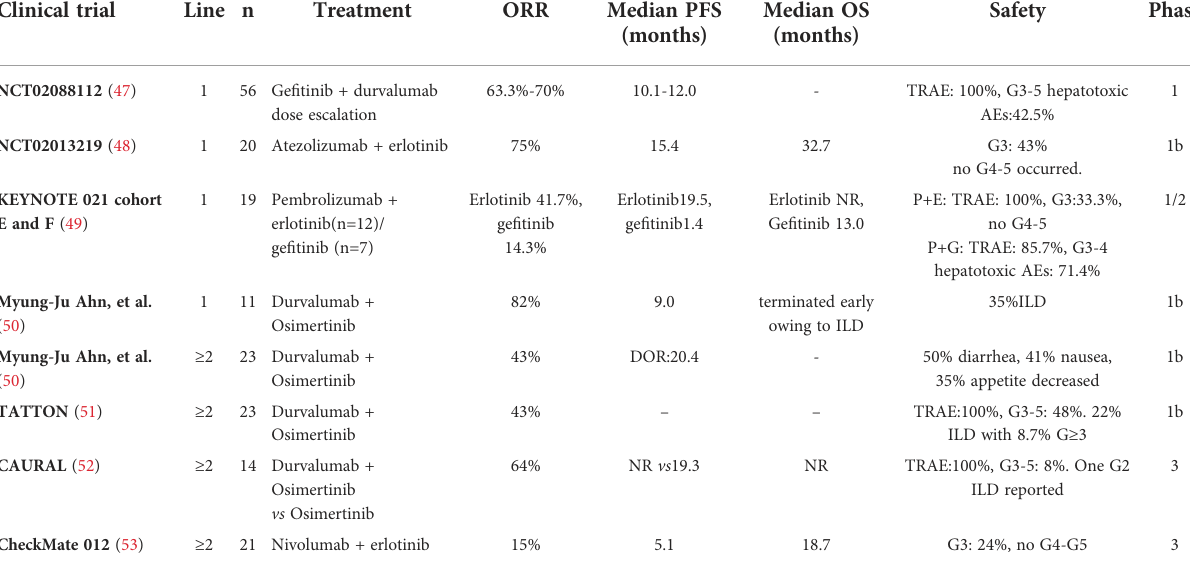
TABLE 3 ICIs combined with EGFR-TKIs enhanced EGFR-mutant NSCLC patient toxicity. Clinical trial Line n